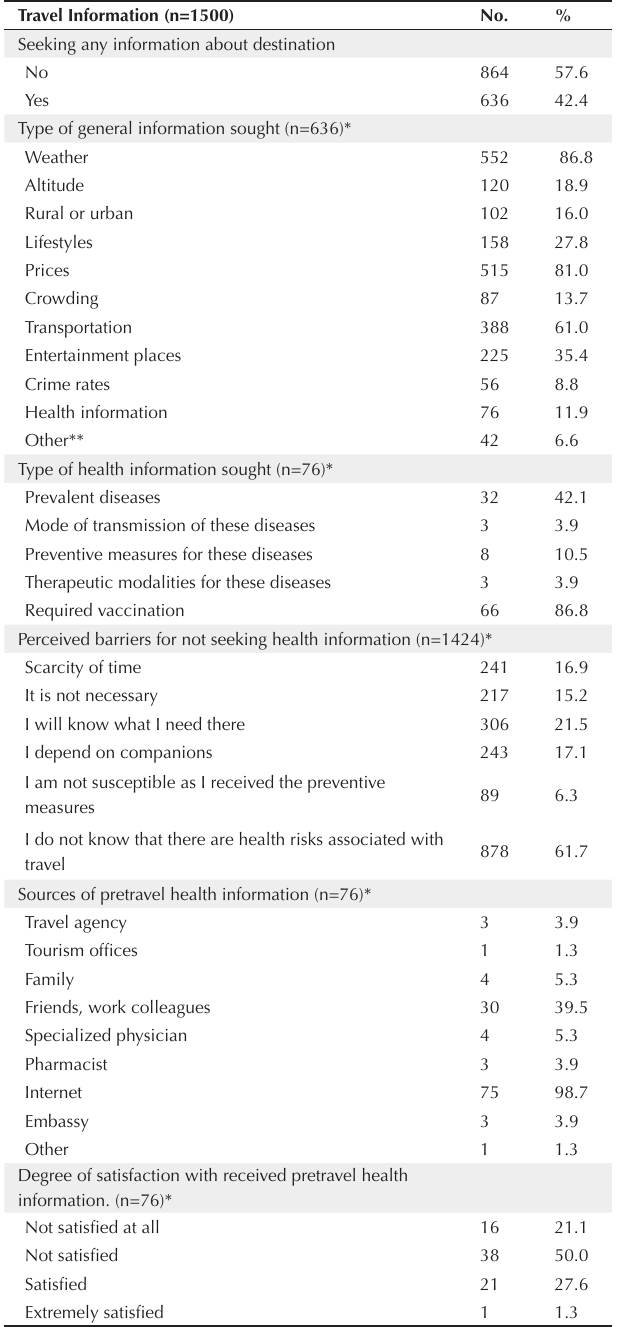
Table 5. Distribution of Travelers at Cairo International Airport According to Travel Health-Seeking Information Travel Information (n=1500)